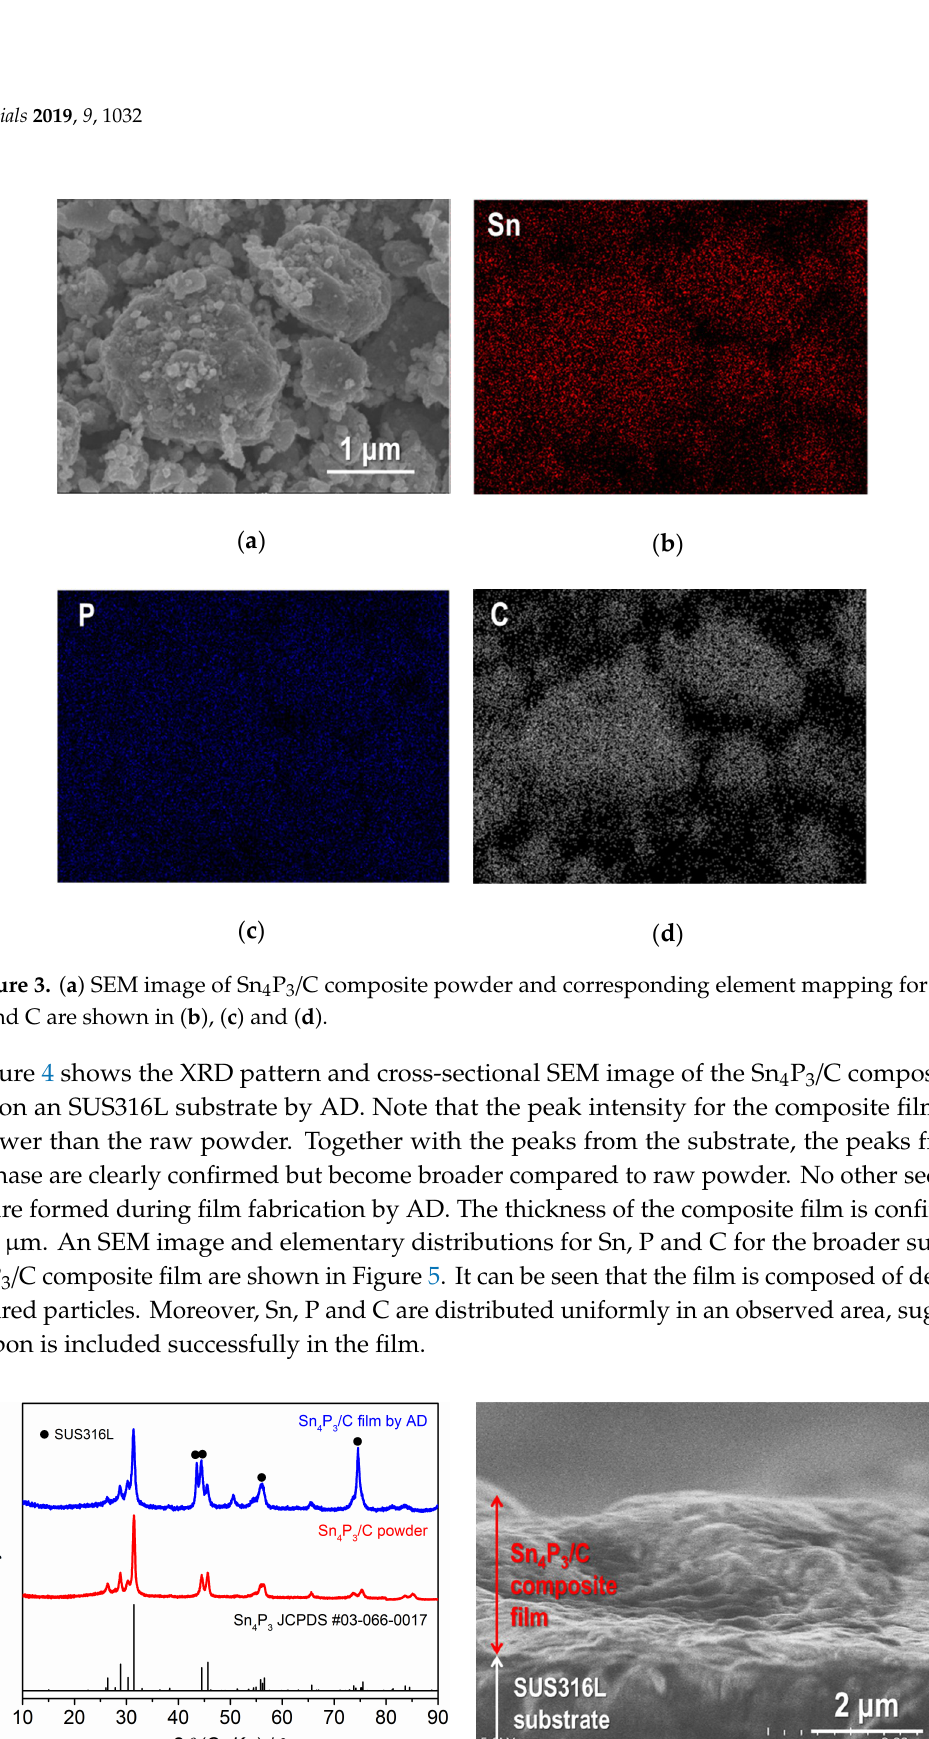
Figure 4. ( a ) XRD patterns for the Sn 4 P 3 /C composite powder and film formed on an SUS316L substrate and ( b ) cross‐sectional SEM image for the Sn 4 P 3 /C composite film formed on an SUS316L substrate.